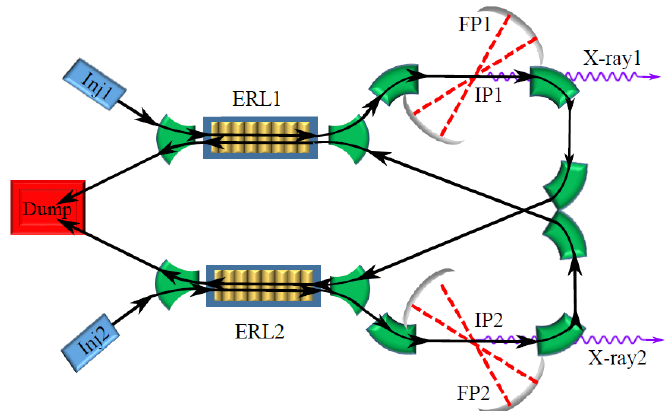
Figure 1. Pictorial view of the BriXs layout: From the left side: Inj1 and Inj2: photocathodes. ERL1 and ERL2: Superconducting Linacs. FP1 and FP2: Fabri-Pérot cavities. IP1 and IP2: interaction points. X-ray1 and X-ray2: X rays beams, going towards Compton users